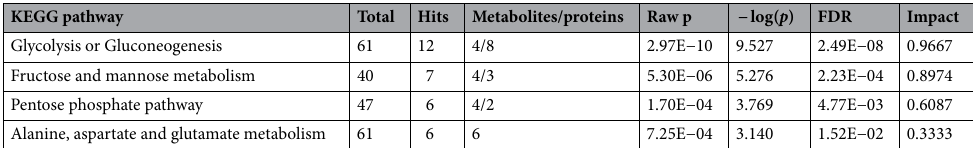
Table 2. Significantly enriched KEGG human metabolic pathways from the analysis of significantly altered metabolites (after Mann–Whitney U test with FDR < 0.05) and significantly altered proteins (from Valdés et al. 2020 26 ) after incubation of HK-2 cells in HG (25 mM glucose)-hypoxia (1% O 2 ) and control (5.5 mM glucose/18.6% O 2 ) conditions for 48